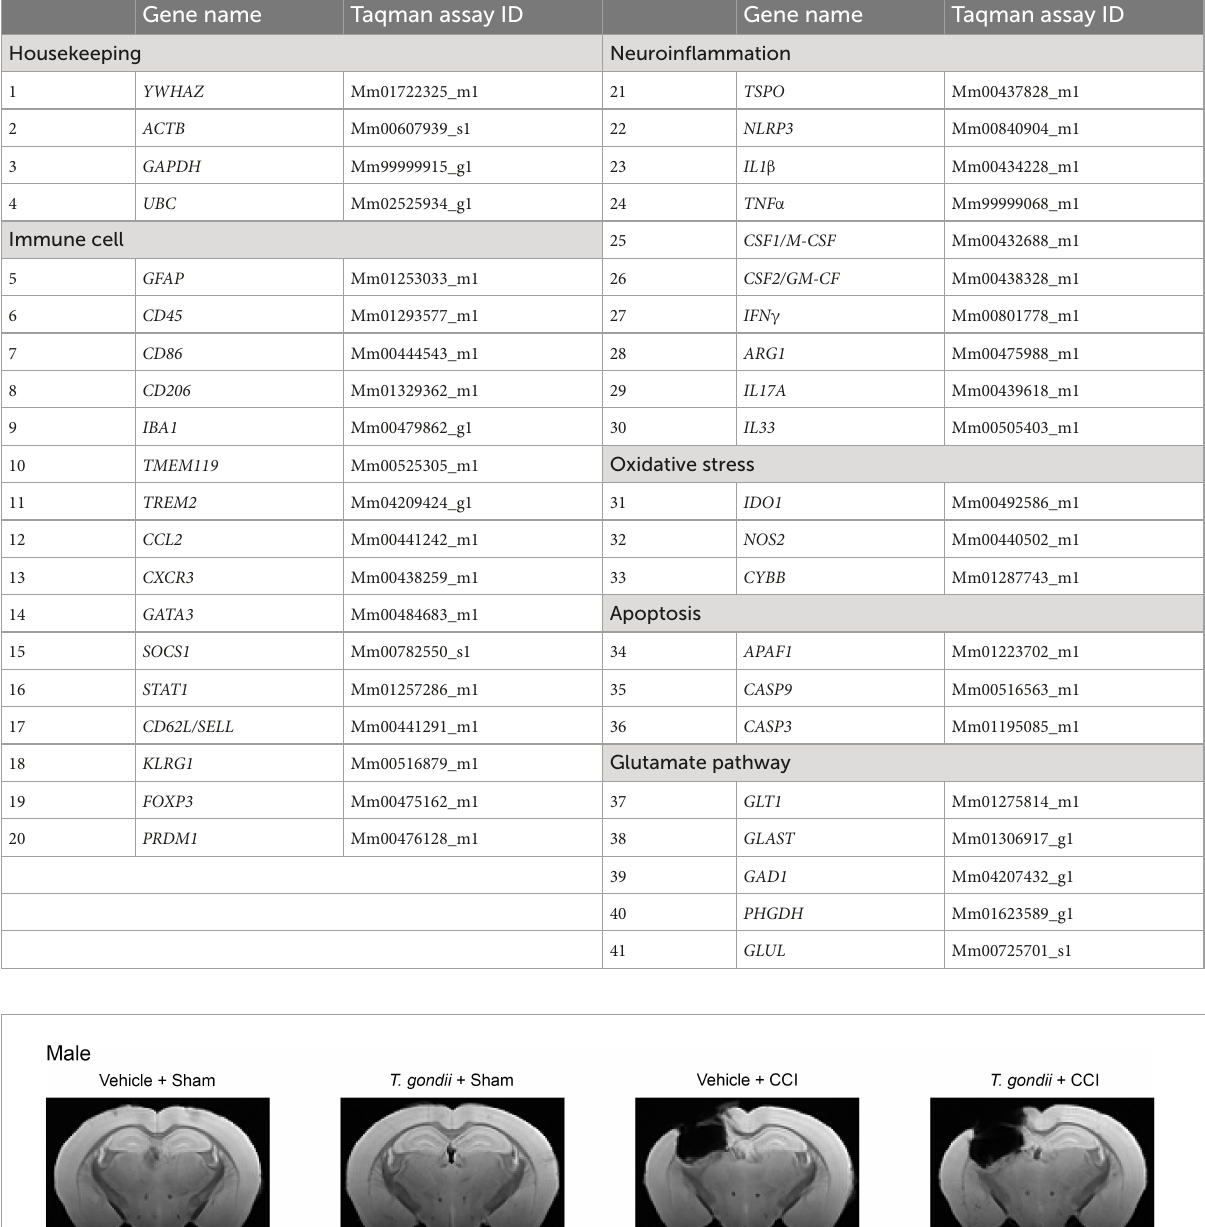
TABLE 2 Immune cell, neuroinflammatory, glutamate pathway, and housekeeping genes analyzed via RT-PCR using Taqman assays.